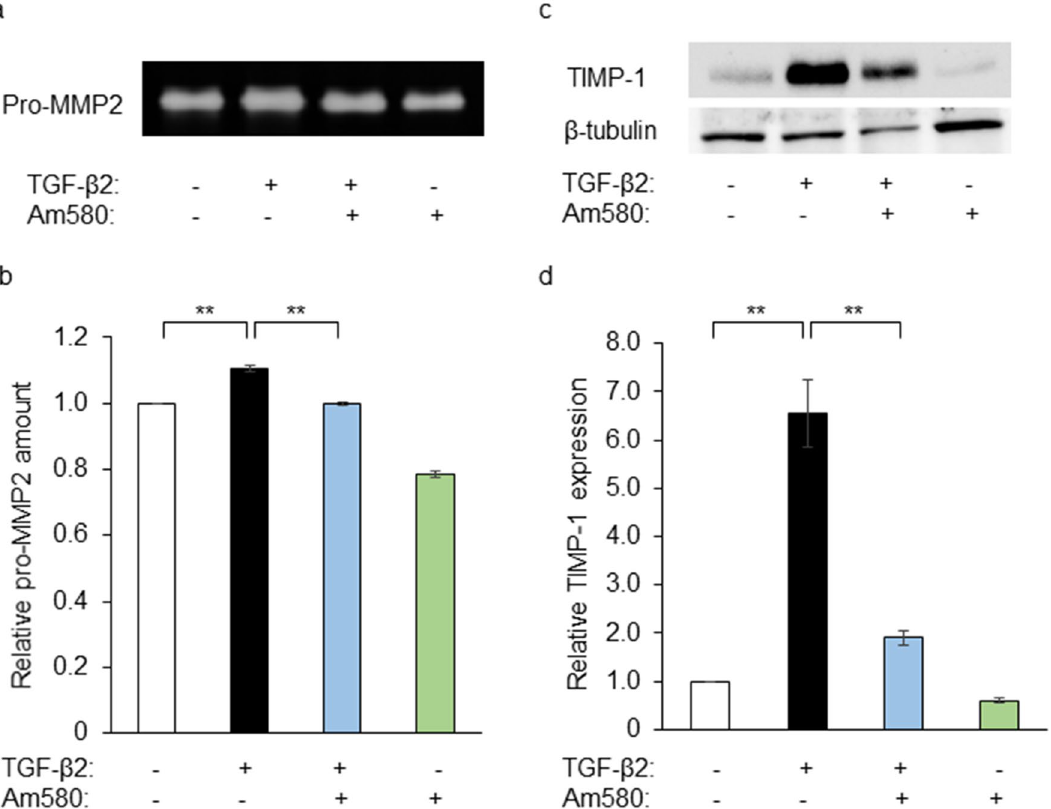
Figure 3. Inhibitory effects of an RAR-α agonist on TGF-β2-induced pro-MMP2 and TIMP-1 expression in RPE cells. ( a ) RPE cells were cultured in collagen gels with or without TGF-β2 (1 ng/ml) and Am580 (10 µM) for 48 h, after which the culture supernatants were subjected to gelatin zymography for detection of pro-MMP2. ( b ) Quantitation of relative pro-MMP2 band intensity for gels similar to that in ( a ). ( c ) RPE cells cultured as in ( a ) were lysed and subjected to immunoblot analysis with antibodies to TIMP-1 and to β-tubulin. ( d ) The intensity of each TIMP-1 band in blots similar to that in ( c ) was normalized by that of the corresponding β-tubulin band, and the normalized values were expressed relative to that for control cells. Quantitative data in ( b ) and ( d ) are means ± s.d. from four independent experiments. The intensity of each bands was measured with the use of the Gels commands in ImageJ software. ** P < 0.01 (Dunnett’s